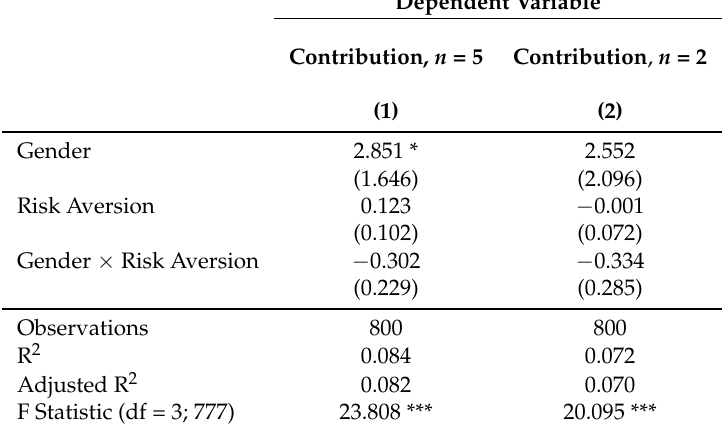
Table 6. Contributions to the joint product explained by gender and risk aversion. Groups size n = 5 (left column) and n = 2 (right column), linear SCF. Standard errors (in parenthesis) clustered on group and